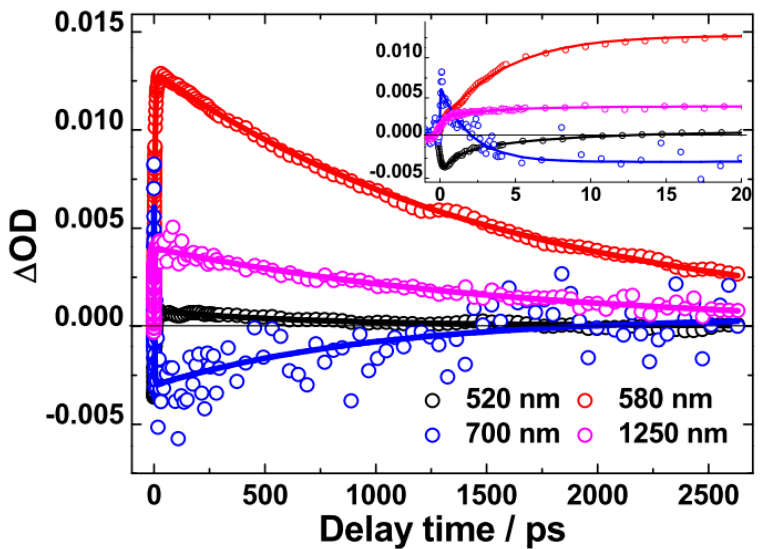
Figure 5. Kinetics at the indicated probing wavelengths plotted from the corresponding spectral dynamic in Figure 4 for PFSDCN in chlorobenzene solution, Solid lines are fitting curves based on multi-exponential model functions. Table 2. Decay time constants ( τ ) derived from multi-exponential curve fitting of the kinetics for